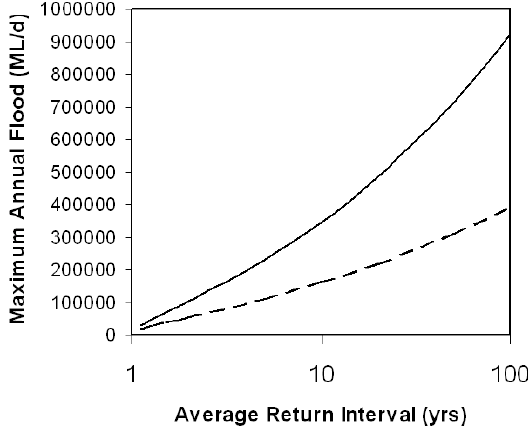
Figure 3. Flood frequency curves for IPO/PDO negative (solid line) and IPO/PDO positive (dashed line).